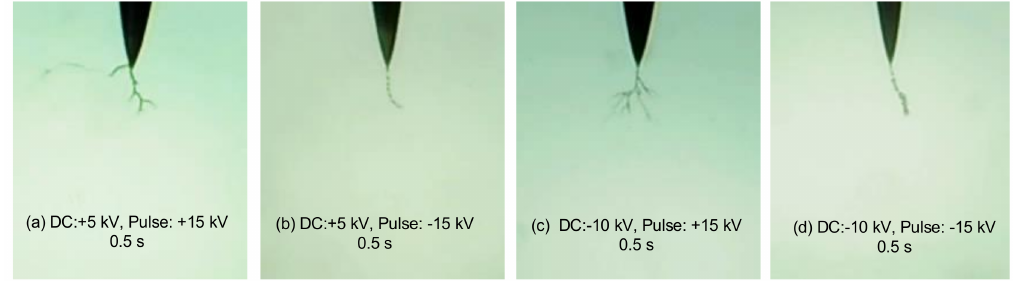
Figure 4. Initial tree structure under different combined voltage: ( a ) +5 kV DC and +15 kV pulse; ( b ) +5 kV DC and − 15 kV pulse; ( c ) − 10 kV DC and +15 kV pulse; ( d ) − 10 kV DC and − 15 kV